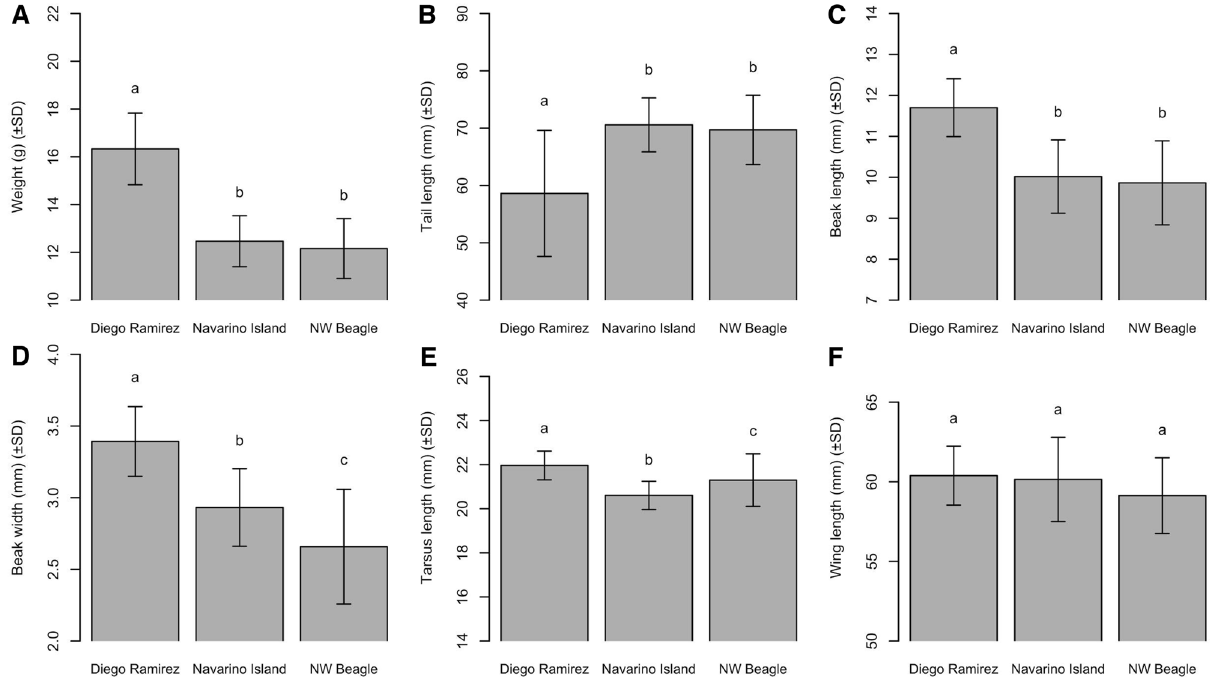
Figure 3. Comparison of body weight ( A ), tail length ( B ), beak length ( C ), beak width ( D ), tarsus length ( E ), and wing length ( F ) among Aphrastura populations. Metrics (means ± SD) of birds from the northwest arm of the Beagle Channel (NW Beagle, n = 50), Navarino Island (n = 54), and the population of the proposed new species A. subantarctica on Gonzalo Island, Diego Ramírez (n = 13). Lowercase letters indicate statistically significant differences at an alpha of